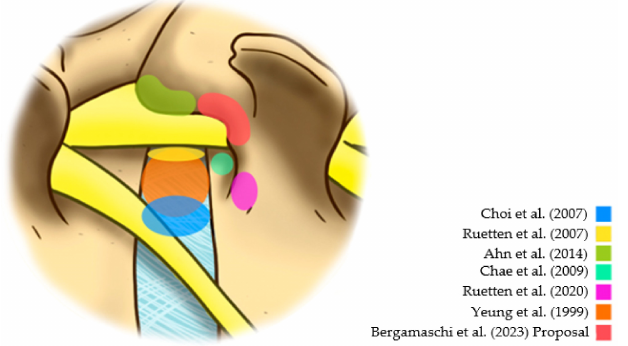
Figure 1. Different reference points in the posterolateral approaches